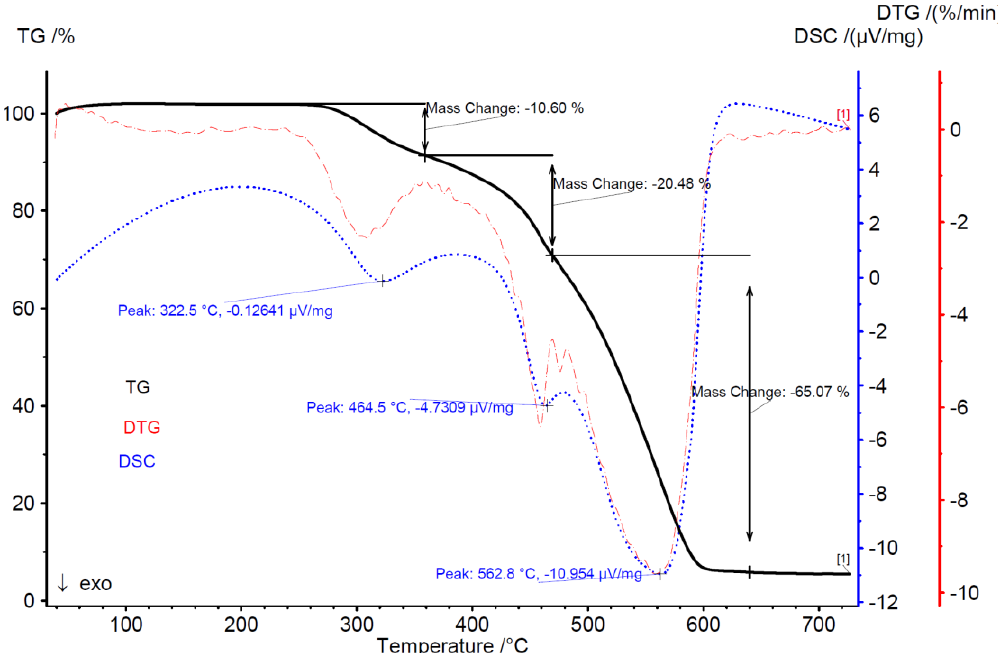
Figure 7. Thermogravimetric analysis of torrefied Jerusalem artichoke combustion process.